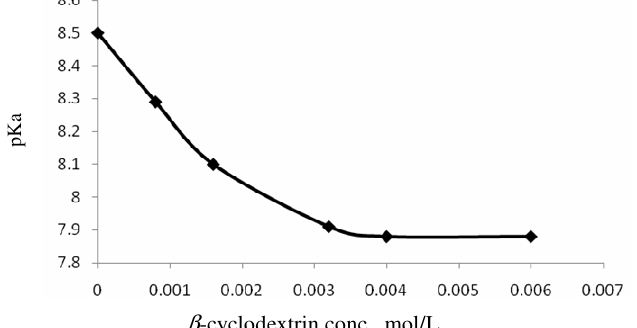
Figure 5. The plot of pK